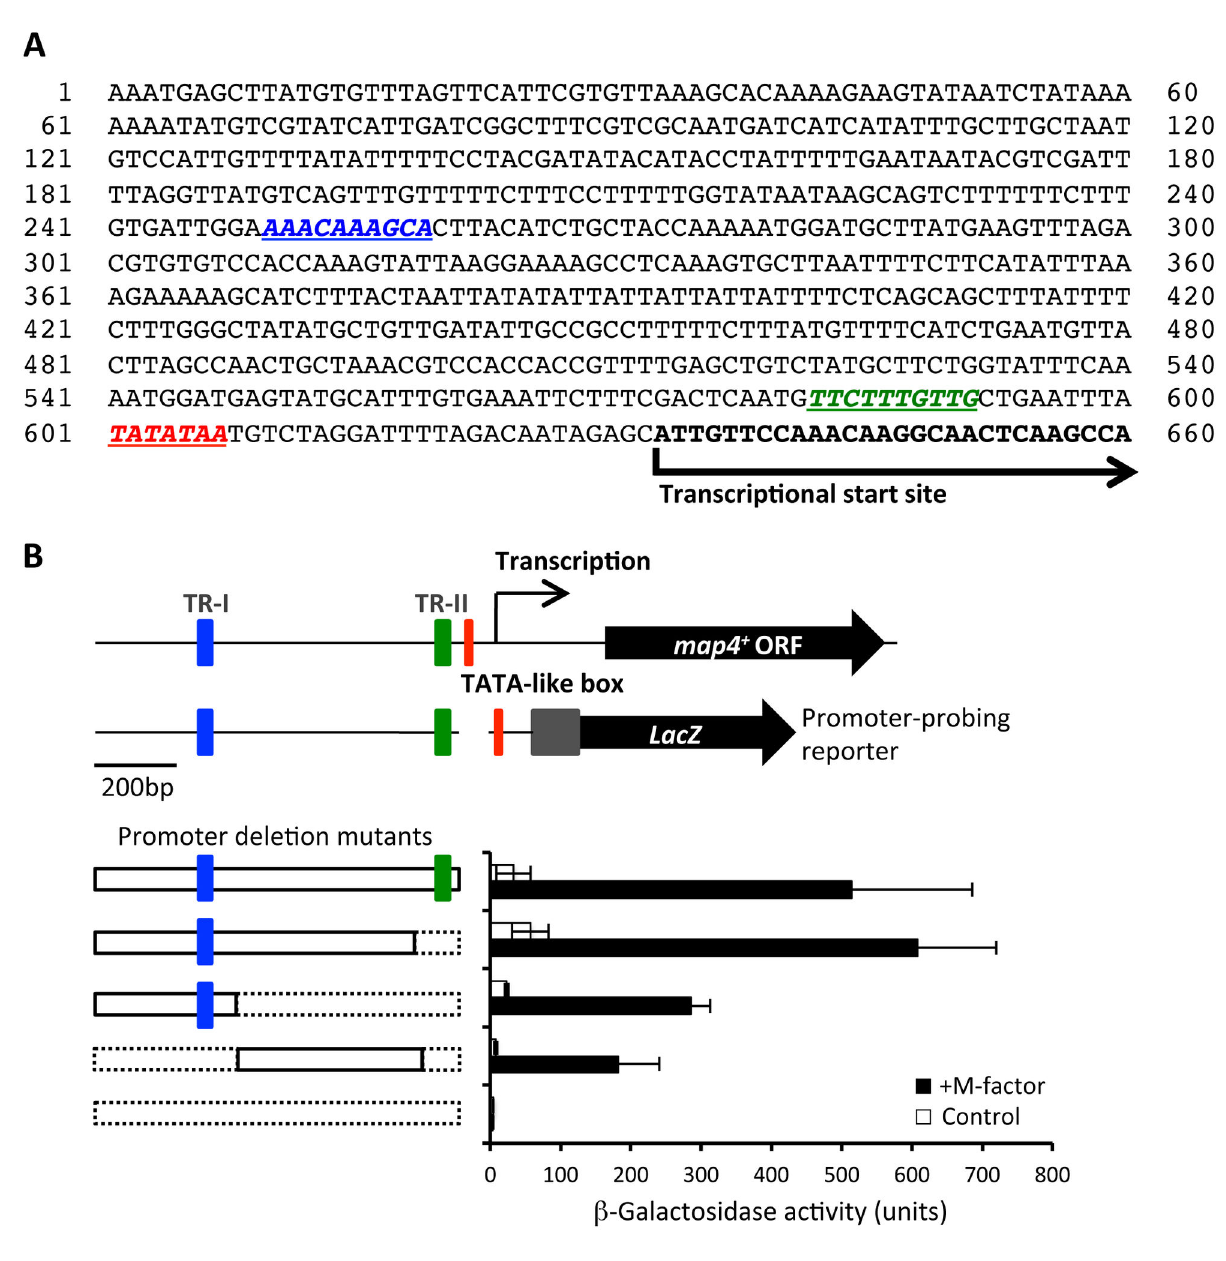
Figure 4. Deletion analysis of upstream cis -acting elements of map4 + . (A) Putative promoter sequence of the map4 + gene. Two possible TR-box elements (blue and green) and a TATA-like box (red) are italicized and underlined. The transcription start site was identified by sequencing of several cDNA clones (Nakamura et al , unpublished). (B) β-galactosidase assay of the promoter intensity of a map4 promoter- lacZ fusion gene with different deletions of the promoter sequence of the map4 gene. A heterothallic h + strain (FS85) was transformed with the multicopy plasmid pTA(map4 PRO -lacZ) or the deletion constructs. Cells of the transformants were precultured in SSL+N without leucine and then transferred to SSL−N medium containing 200 nM of synthetic M-factor (filled bar) or SSL−N alone (open bar). After 6 hr, β-gal activity was assayed. doi: 10.1371/journal.pone.0069491.g004 to the number of natR colonies as a measure of wild-type P- cells preferentially mate with wild-type M-cells and only very cells. The frequency of the natR kanR recombinants appeared rarely with M-factor-less M-cells. This tendency was not at about 5x10 −3 , whereas that of the natR hygR recombinants affected by the addition of exogenous M-factor (200 nM) to the was <10 −6 . These results (Figure 7) indicate that wild-type P- SSL−N medium (Figure 7). In this experimental system, wild-